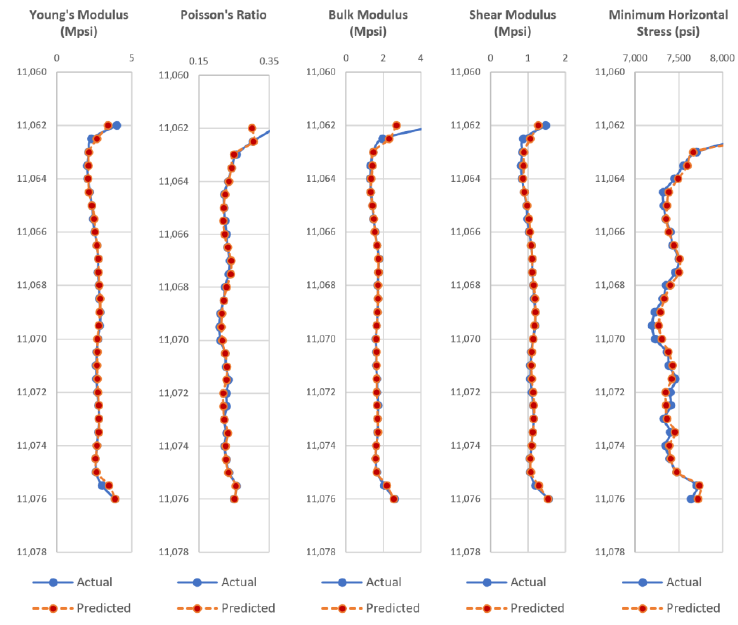
Figure A5. Actual and predicted geomechanical properties along with depth (feet) for test well 3 in Dunn County for the Upper Bakken Shale. Energies 2018 , 11 , x FOR PEER REVIEW 22 of 26